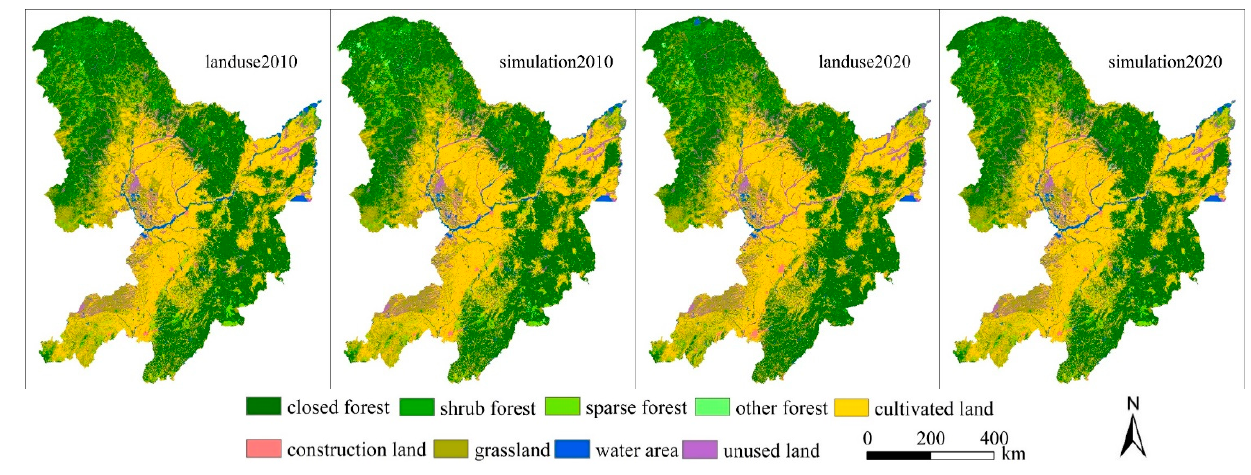
Figure 4. Land use simulation in the NCF for 2010 and 2020. Table 3. PLUS model validation results for the NCF.